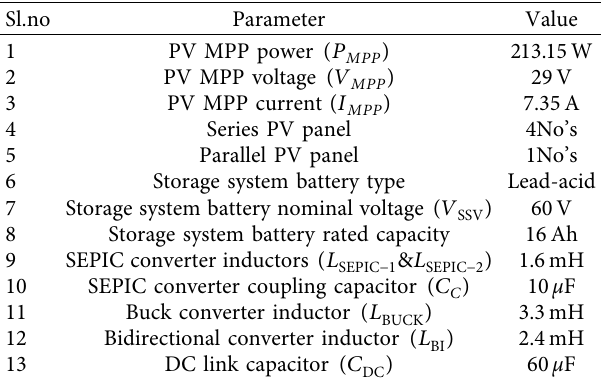
Figure 8: Four operating modes fowchart. Table 1: Parameters used in